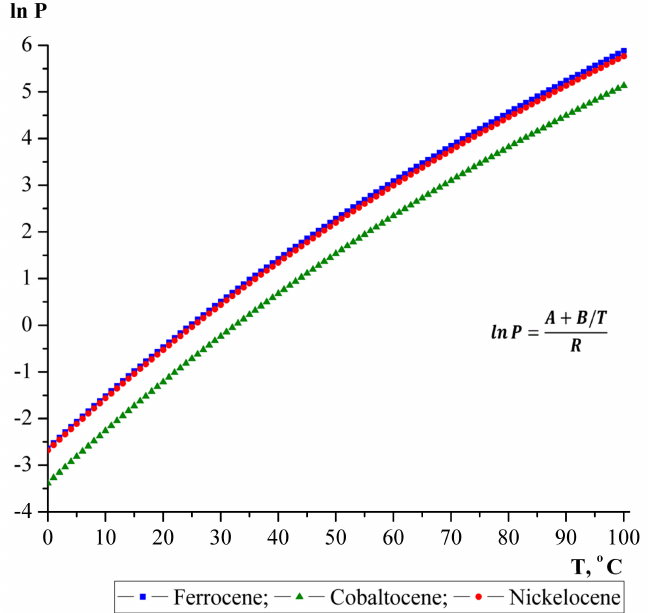
Figure 2. Temperature dependence of the logarithm of vapor pressure (metallocenes Fe, Co and